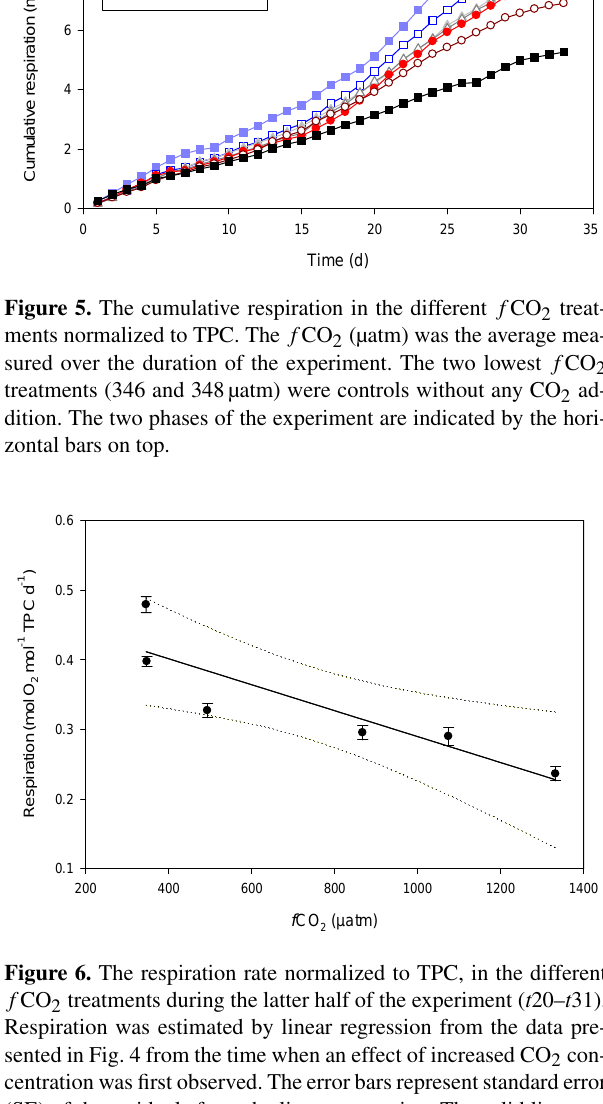
Figure 6. The respiration rate normalized to TPC, in the different f CO 2 treatments during the latter half of the experiment ( t 20– t 31). Respiration was estimated by linear regression from the data pre- sented in Fig. 4 from the time when an effect of increased CO 2 con- centration was first observed. The error bars represent standard error (SE) of the residuals from the linear regression. The solid line rep- resents the linear regression (slope − 0.0002; p = 0.02; R 2 = 0.77) and dotted lines the 95% confidence